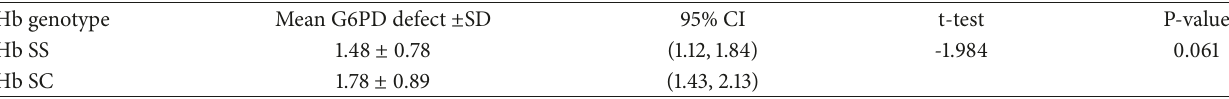
Table 3: The table shows a comparison of G6PD deficiency among the haemoglobin genotypes of the participants.